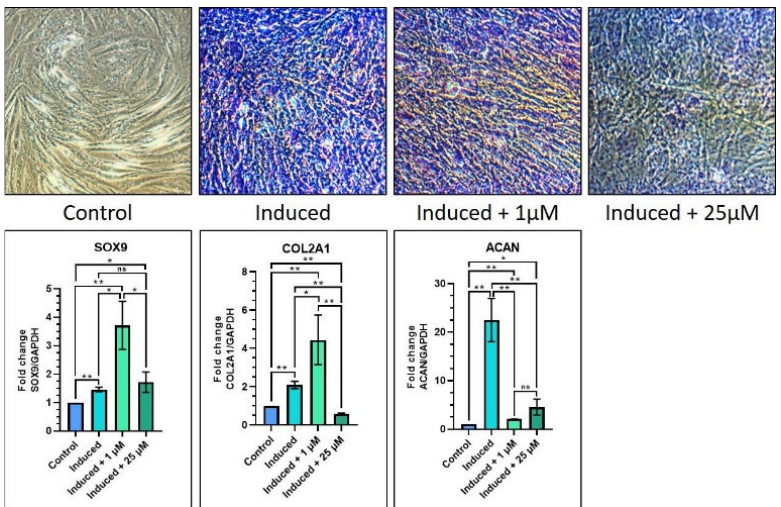
Figure 5. Comparative chondrogenic differentiation (toluidine blue staining) of DPSCs with low (1 μ M) and high (25 μ M) concentrations of melatonin and RT ‐ qPCR ‐ based gene expression analysis of chondrogenesis ‐ related genes. Scale bar: 200 μ m. ns, not significant; * p < 0.05 and ** p < 0.01.